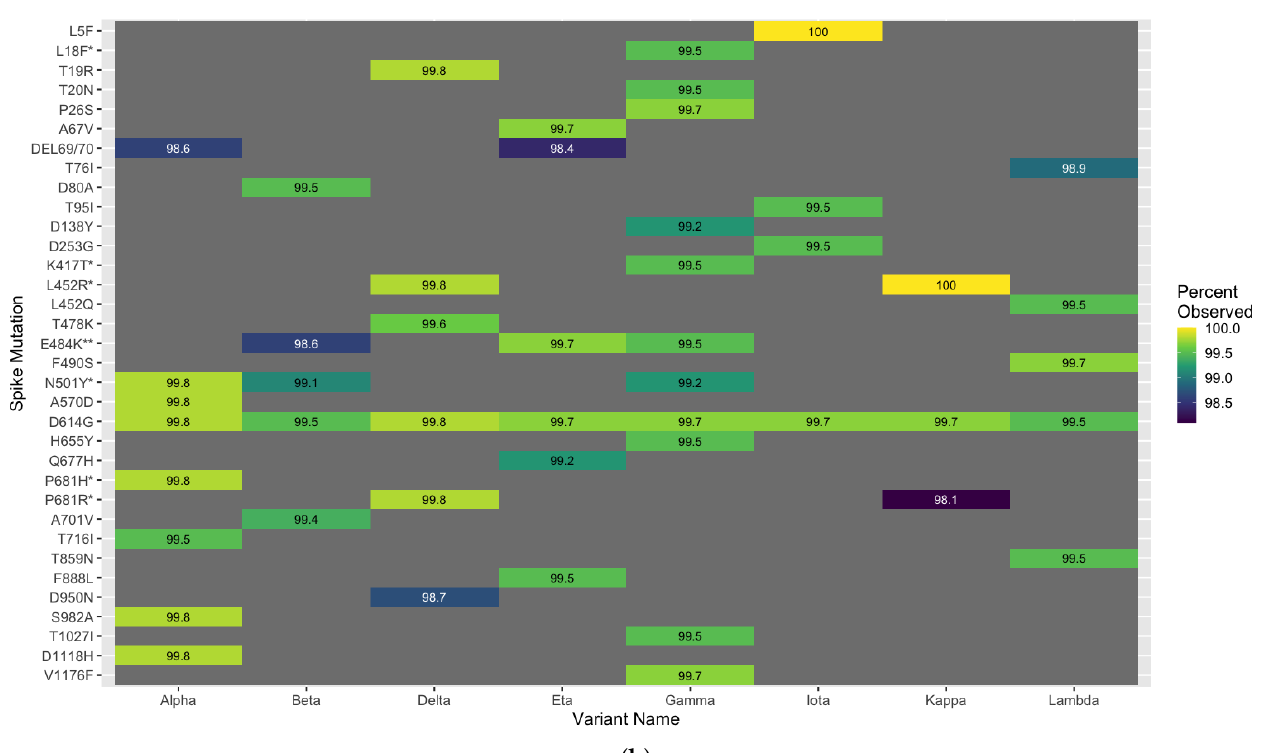
Figure 8. Method accuracy across a variant-diverse set of SARS-CoV-2 genomes. ( a ) Methodological evaluation was completed across eight variants of concern or interest with accuracy metrics including: genomes passing quality thresholds (percent high quality), the ability to identify all expected proteins per genome (protein set membership accuracy), length similarity between predicted pp1ab protein sequences and the reference sequence (pp1ab observed/expected), and targeted analysis to examine spike glycoprotein functional domains (domain set membership accuracy). ( b ) Expected mutations are characterized in a random sampling of genomic sequences across current variants of concern or interest. Each mutation is shown on the y -axis with a single asterisk indicating a mutation of interest and two asterisks indicating a mutation of concern. Grey indicates not applicable, i.e., the mutation is not expected for that variant. For the sampled genomes above quality thresholds, the percent of the mutated amino acid or deletion observed is